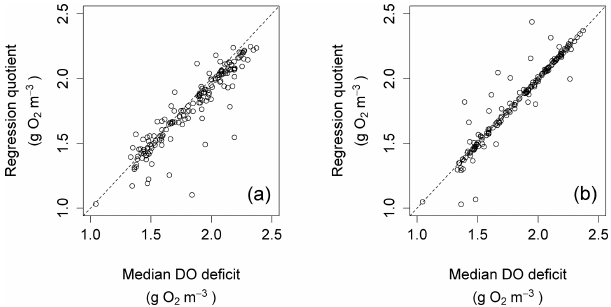
Figure 12. Scatter plots for regression quotient against median DO deficit at points of zero DO change for the